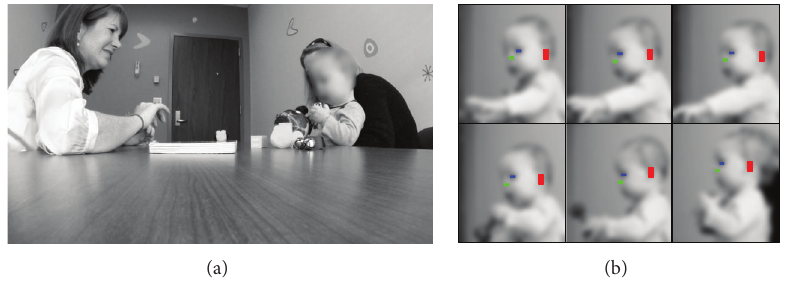
Figure 1: (a) General scene capturing the AOSI evaluation session. (b) Example of our algorithm automatically tracking three facial features: the left eye, left ear, and nose. In this paper, all figures have been blurred to protect the participants’ privacy.